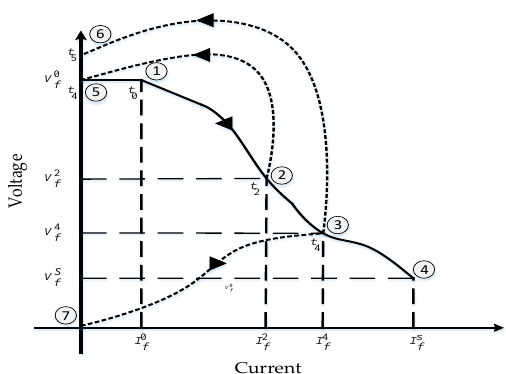
Figure 3. Variations of direct current (dc) voltage and currents in the event of malfunction of breaker. Points 1 and 2 represent events of fault inception and tripping of dc breaker. Voltage and current variations between fault detection by primary protection (PP) and trip action by breaker B 1 is represented by a solid line from points 1 to 2. Faulty line is successfully isolated because of opening of breaker B 1 under the tripping command of primary protection relay. Under this scenario, loci of voltages and currents are denoted via dashed line from point 2 to 5. Voltage increases to V 0 current decreases from I 2 to 0 after clearance of f